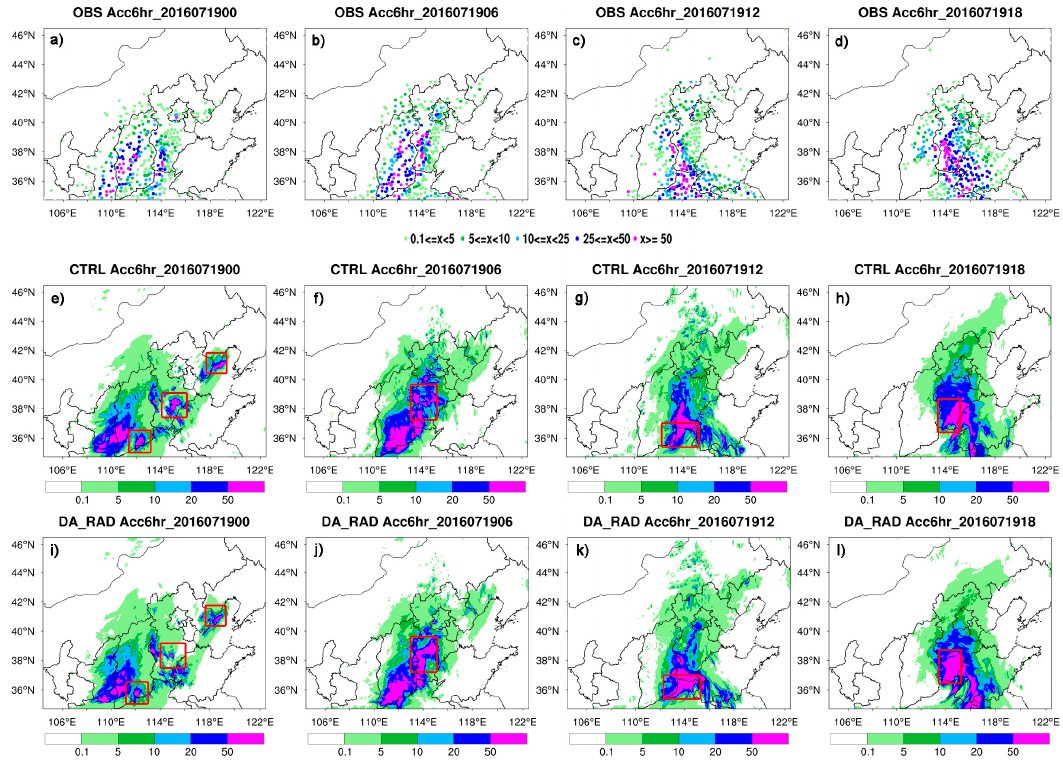
Figure 11. Spatial patterns of 6-h accumulated rainfall distribution from ( a–d ) observations based on ground stations, ( e–h ) forecasts of CTRL, and ( i–l ) forecasts of DA_RAD at 0000 UTC, 0600 UTC, 1200 UTC, and 1800 UTC during July 19, 2016, respectively.